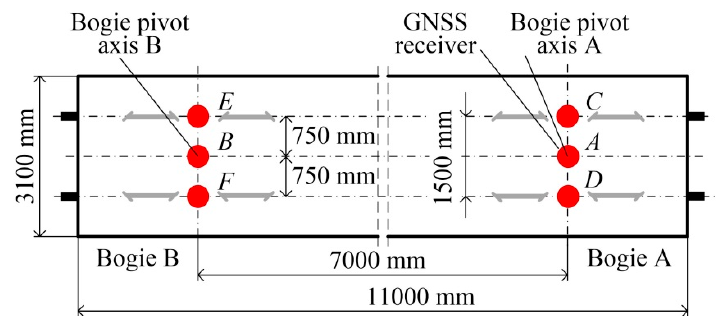
Figure 1. Mobile measuring platform with receivers A , B , …, F and marked base vector 𝐴𝐵(cid:4652)(cid:4652)(cid:4652)(cid:4652)(cid:4652)⃗ .